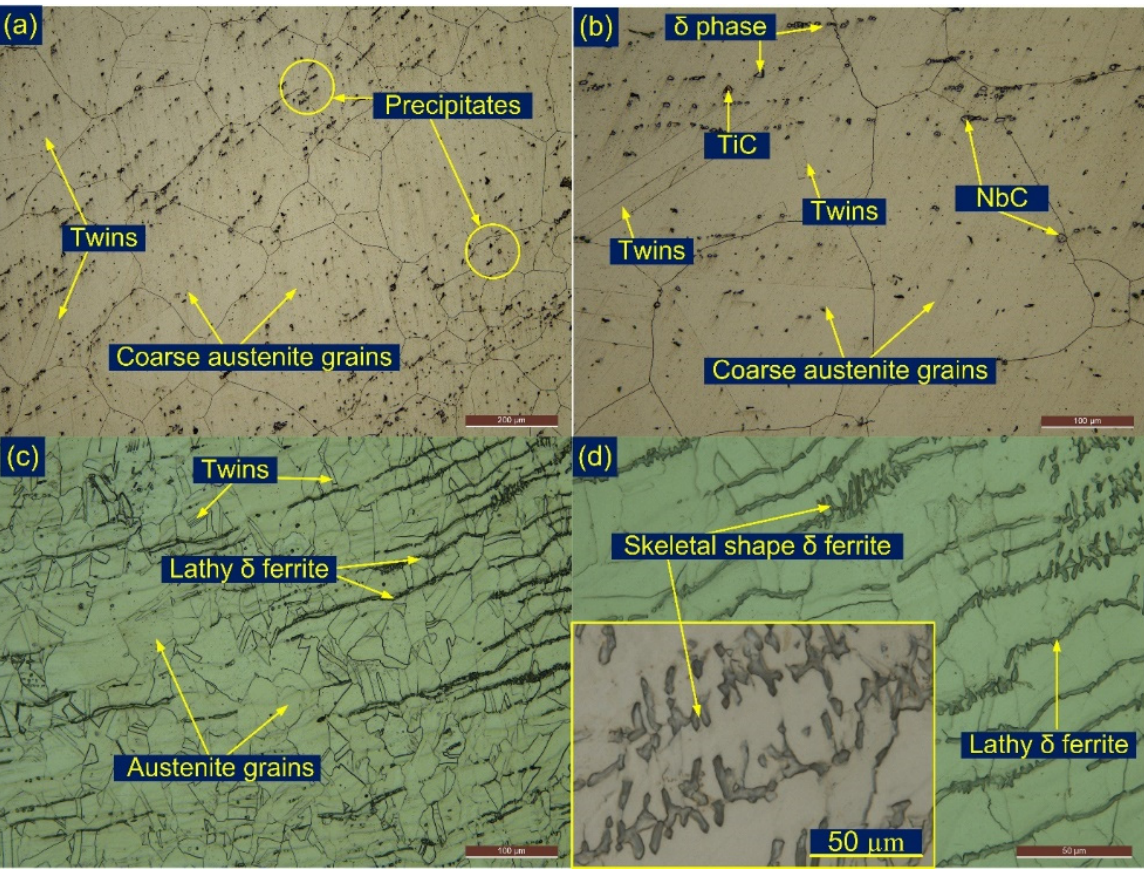
Figure 6. HAZ of IN718 ( a , b ); 304L SS ( c , d ). The region of the 304L SS HAZ near the fusion line has a large density of lathy and skeletal δ ferrite as marked in Figure 7a. The region shows the grain growth as an effect of the multi-pass welding cycle. Twins are also witnessed from the SEM image (Figure 7a,b). The EDS of the HAZ shows the major concentration of the Fe, Cr, Ni, C, and Mn. An SEM/EDS observation has also been performed for the IN718 HAZ and presented in Figure 7c,d. The major elements observed in the HAZ are Ni, Cr, Fe, Nb, Mn, Mo, and Ti. The EDS of point 1 confirms the phase of Nb and Ti in the IN718 HAZ.